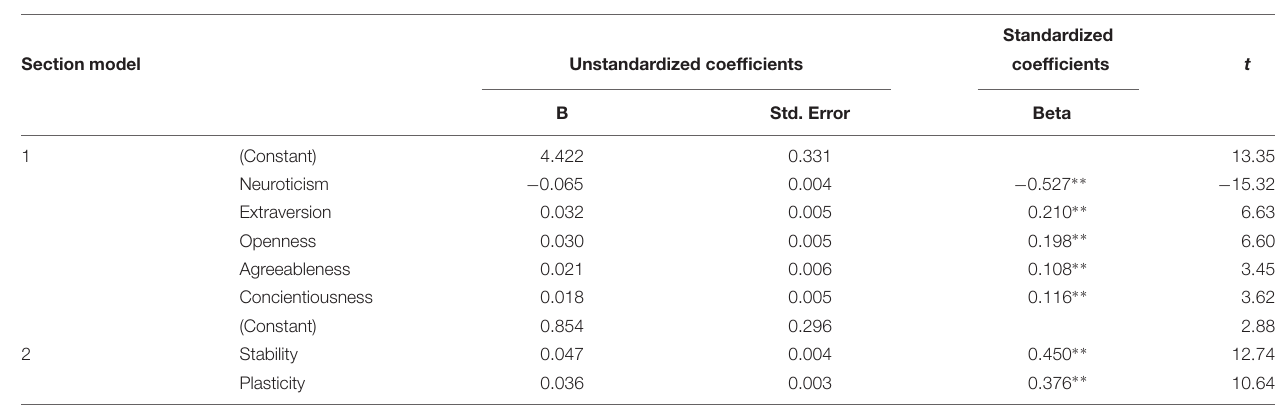
TABLE 2 | Multiple regression of trait EI onto the B5 and trait EI onto the